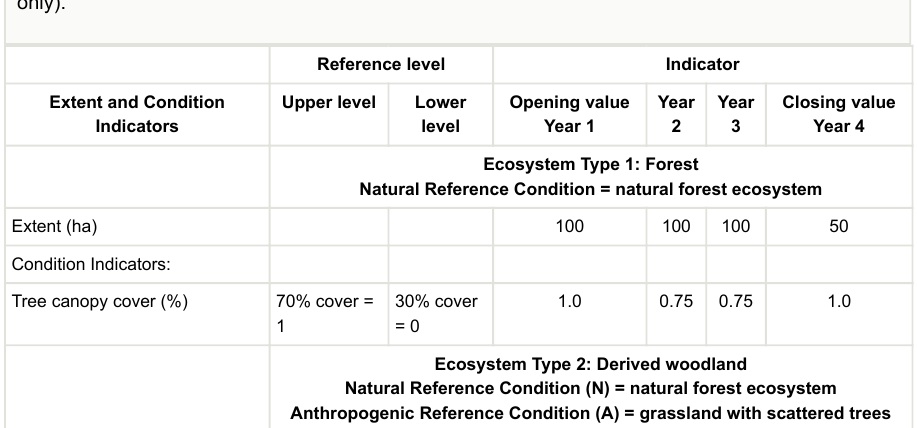
Ecosystem conversion from a forest to a derived woodland and a native woodland to cleared land showing a change in ecosystem extent and condition accounts (numbers in cells are examples